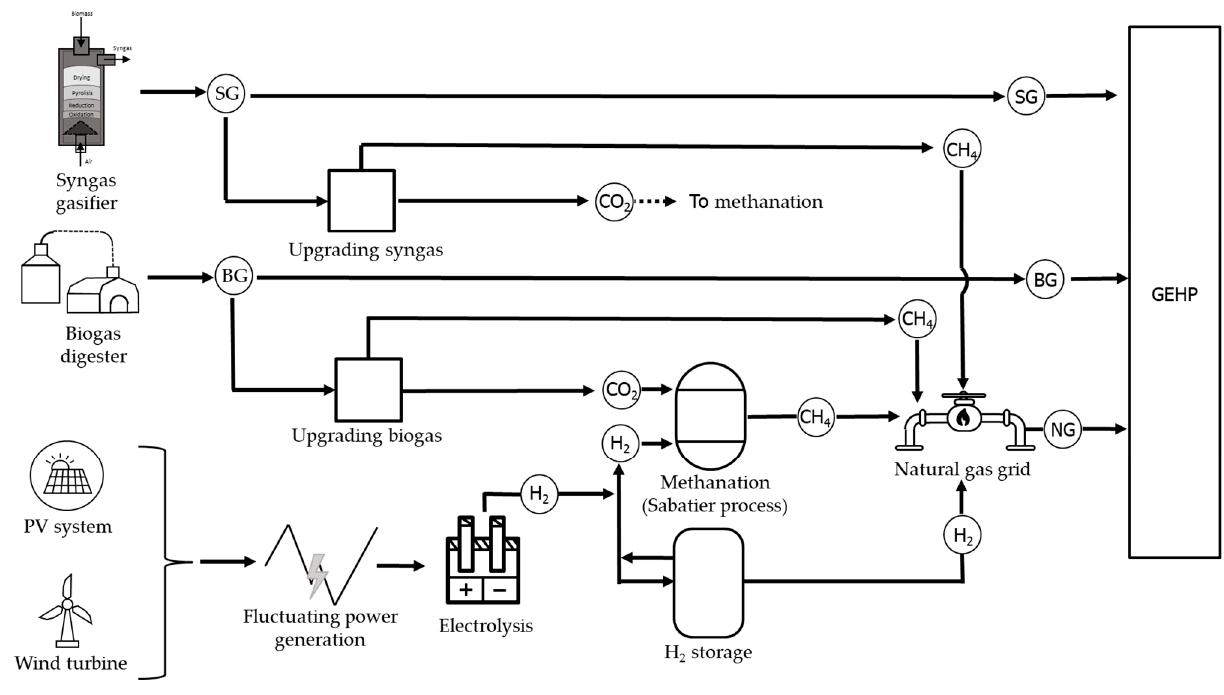
Figure 2. Renewable-based gaseous fuels that could feed GEHP (SG: Syngas; NG: Natural gas; BG: Biogas).